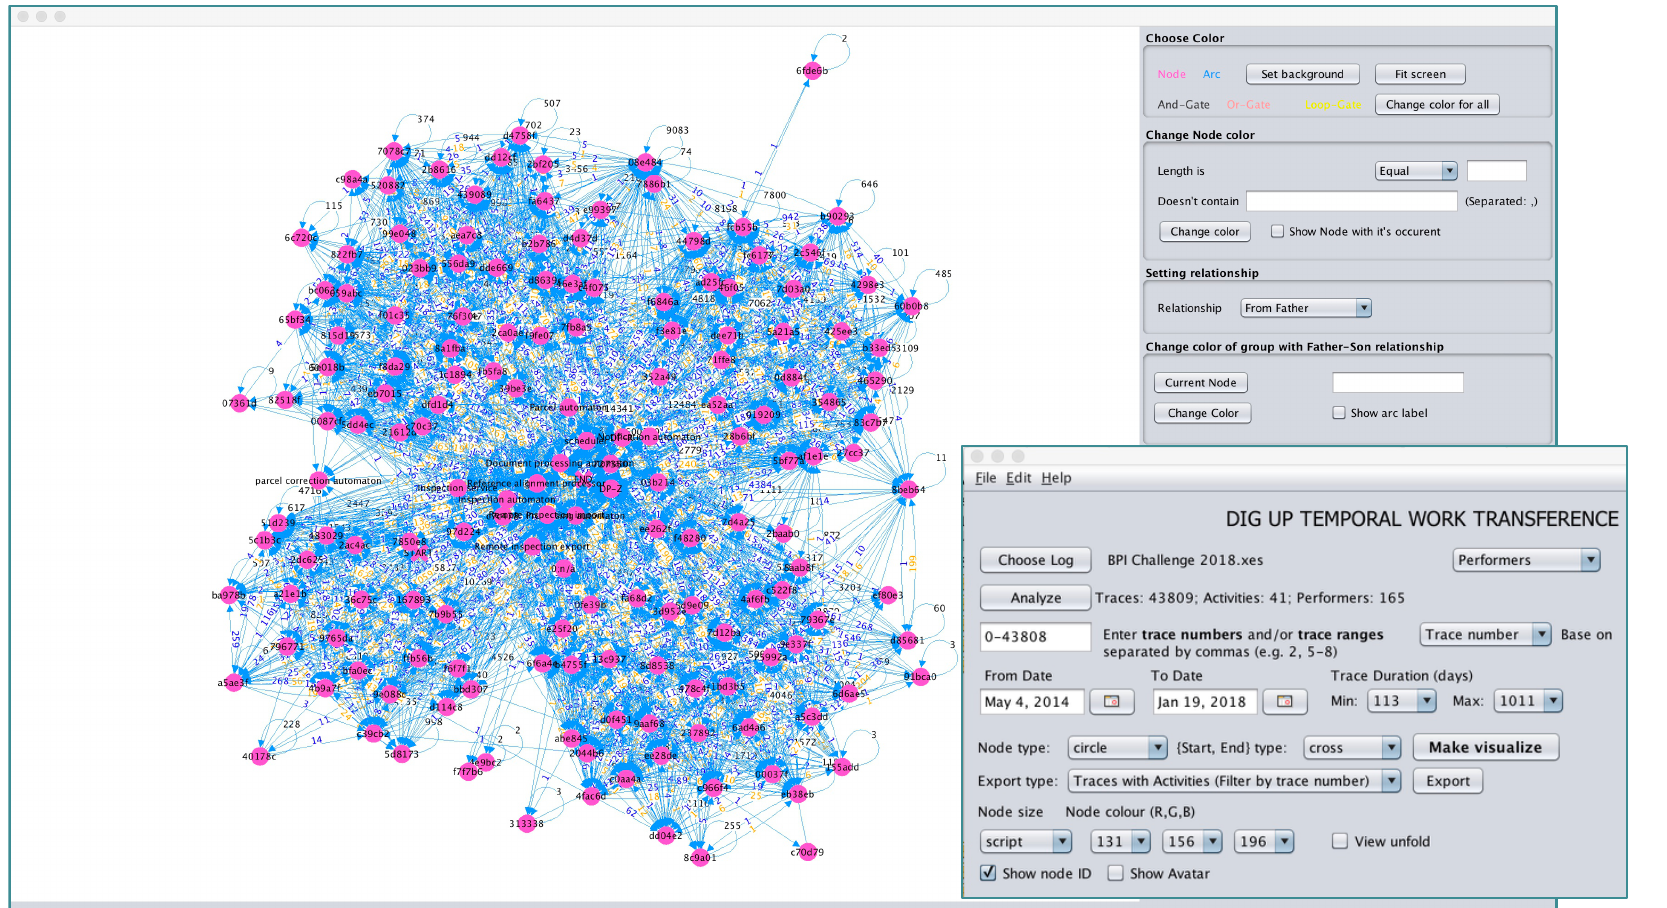
Figure 5. Captured screen of the work transference network mining